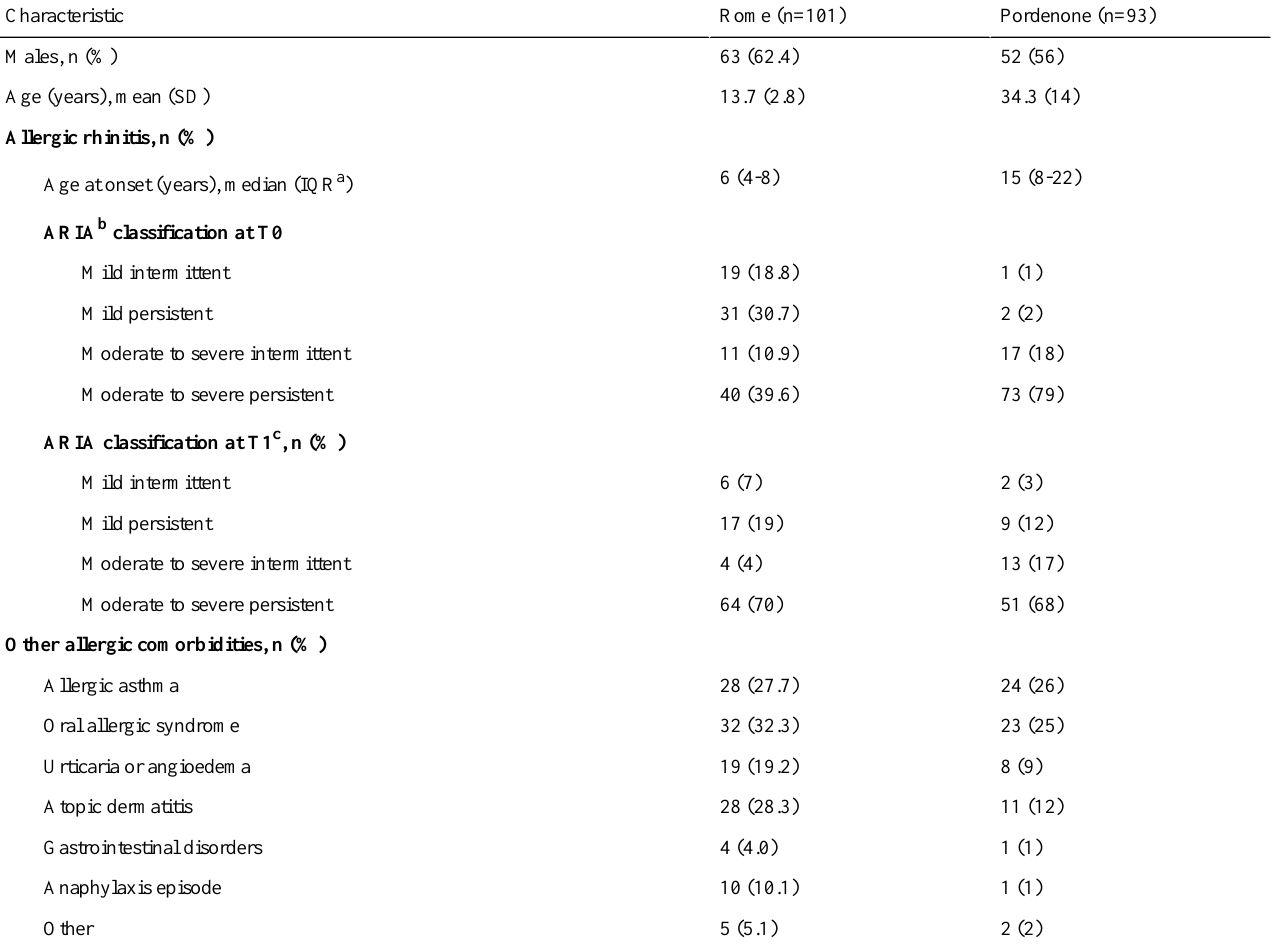
Table 1. Characteristics of the study population.